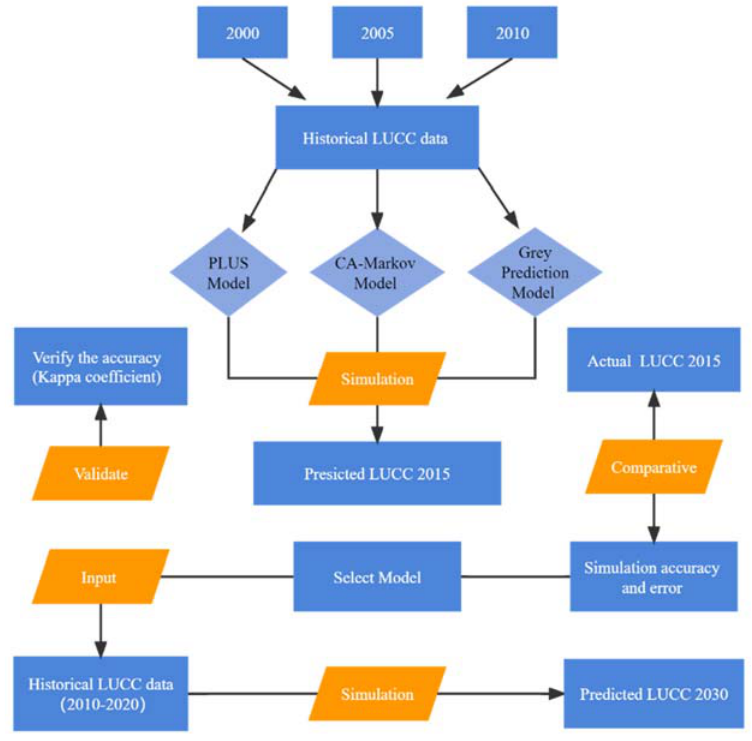
Figure 2. Flow chart showing primary steps in the simulation